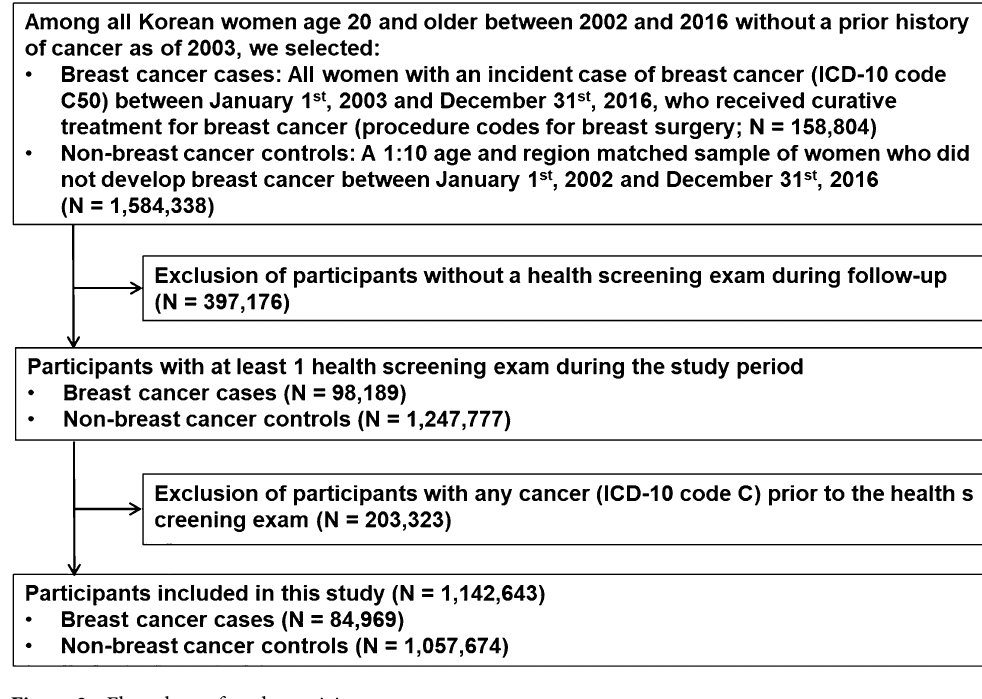
Figure 2. Flow chart of study